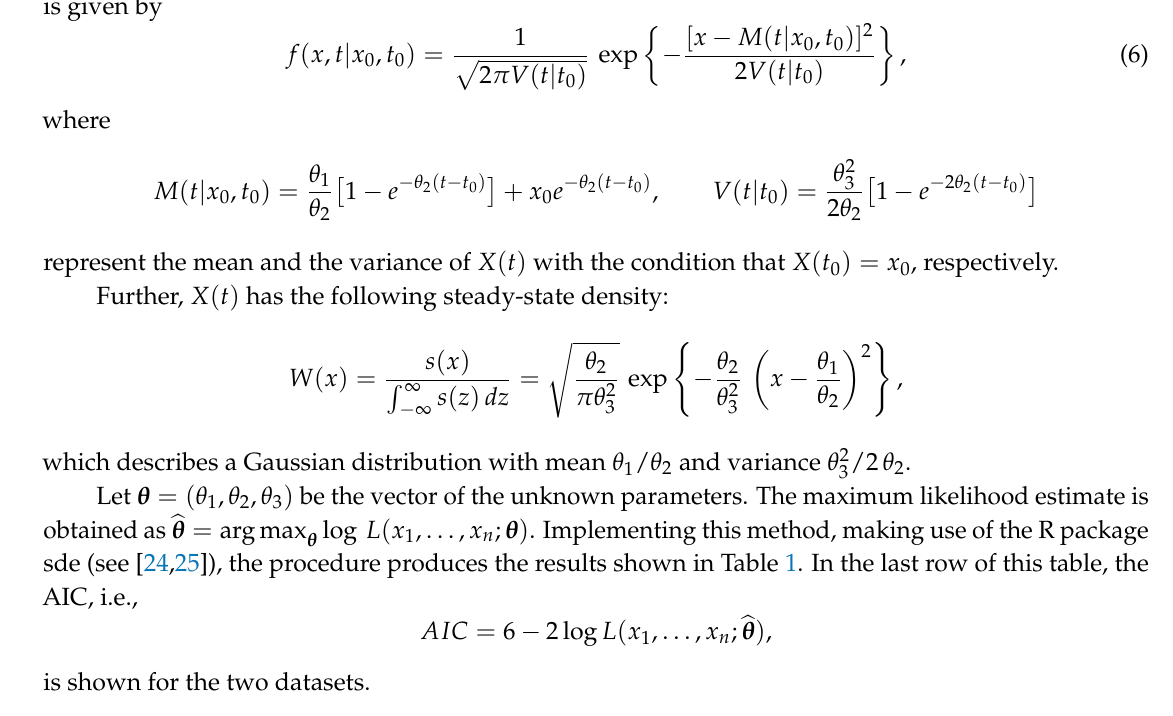
Table 1. ML estimates of Model (5) for Dataset A (on the left) and for Dataset B (on the right). The last row shows the